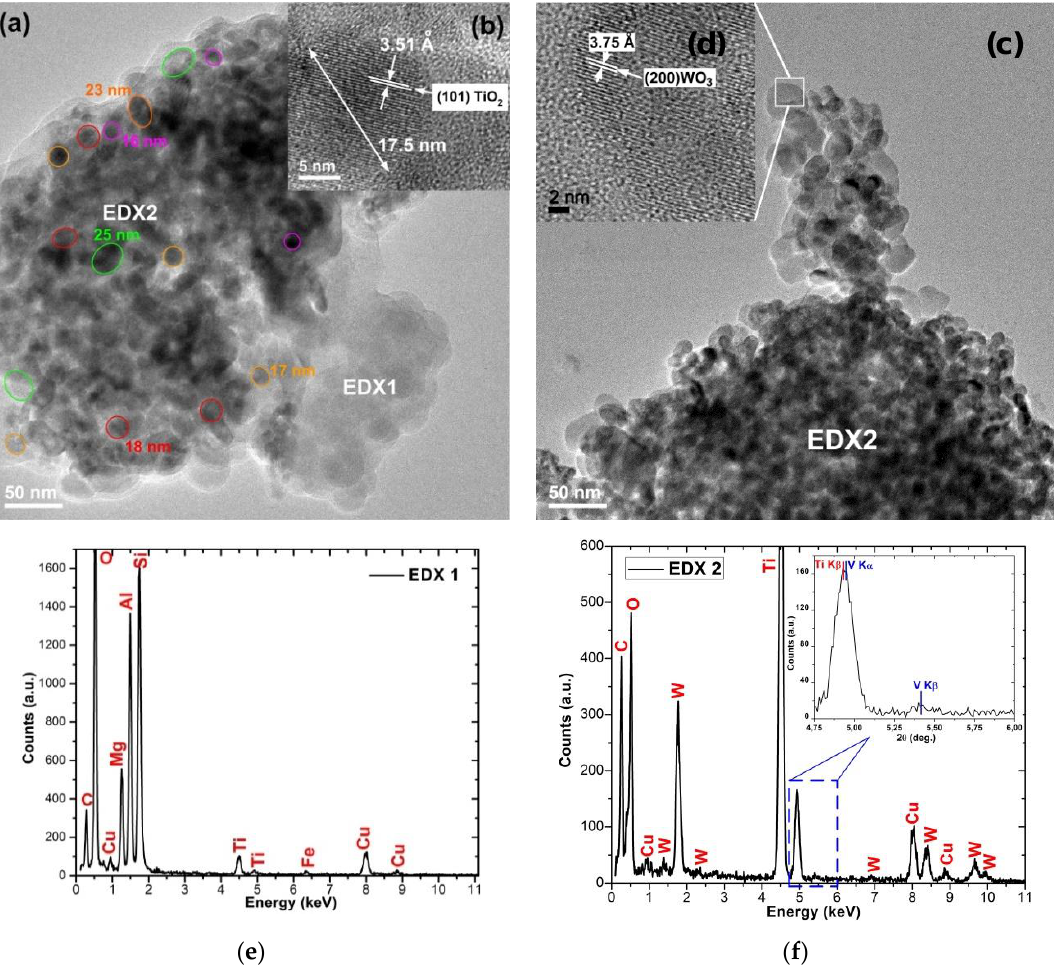
Figure 7. ( a ) Detailed BF-TEM image of a WO 3 -TiO 2 agglomerate (EDX2) bounded with a small aggregate of cordierite (EDX1), ( b ) HR-TEM image of EDX2 nano-zone, ( c ) BF-TEM image of WO 3 -TiO 2 agglomerate with ( d ) crystalline cubic phase identification for WO 3 through HR-TEM analysis; ( e , f ): EDAX spectra for the EDX nano-regions identified in ( b , d ).